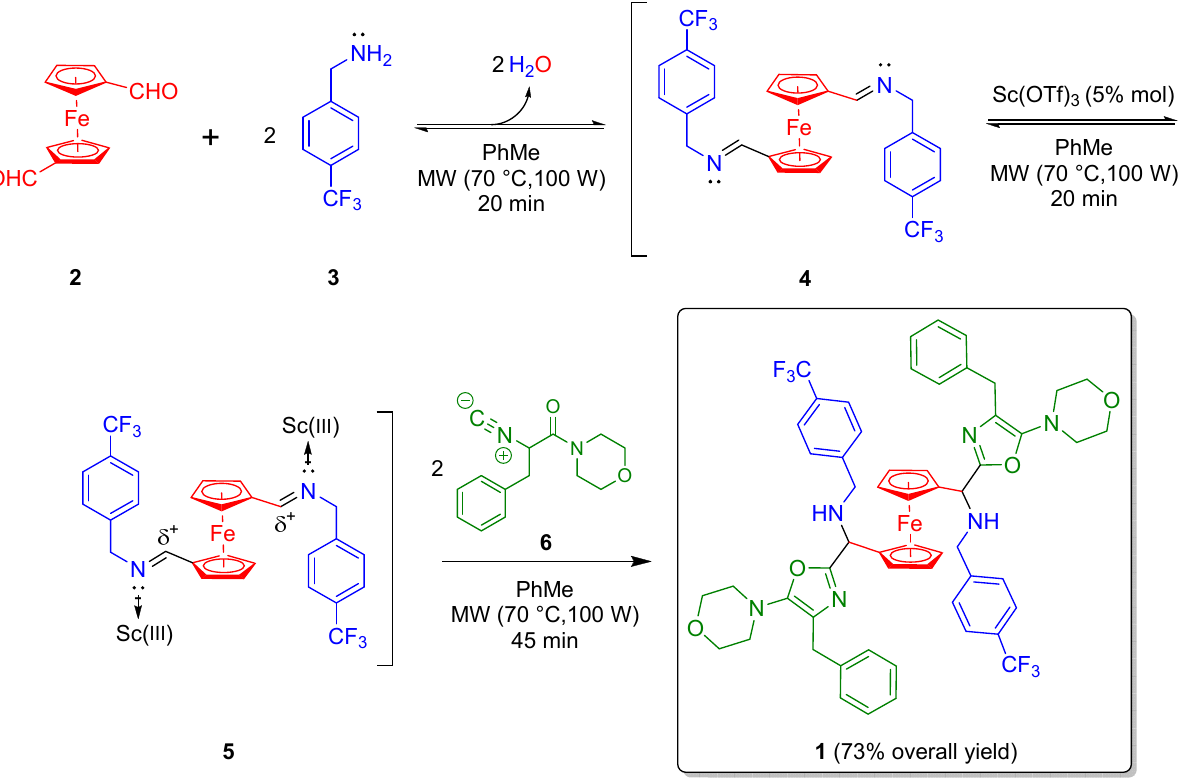
Scheme 1. Synthesis of the symmetrical molecule 1 via a pseudo repetitive